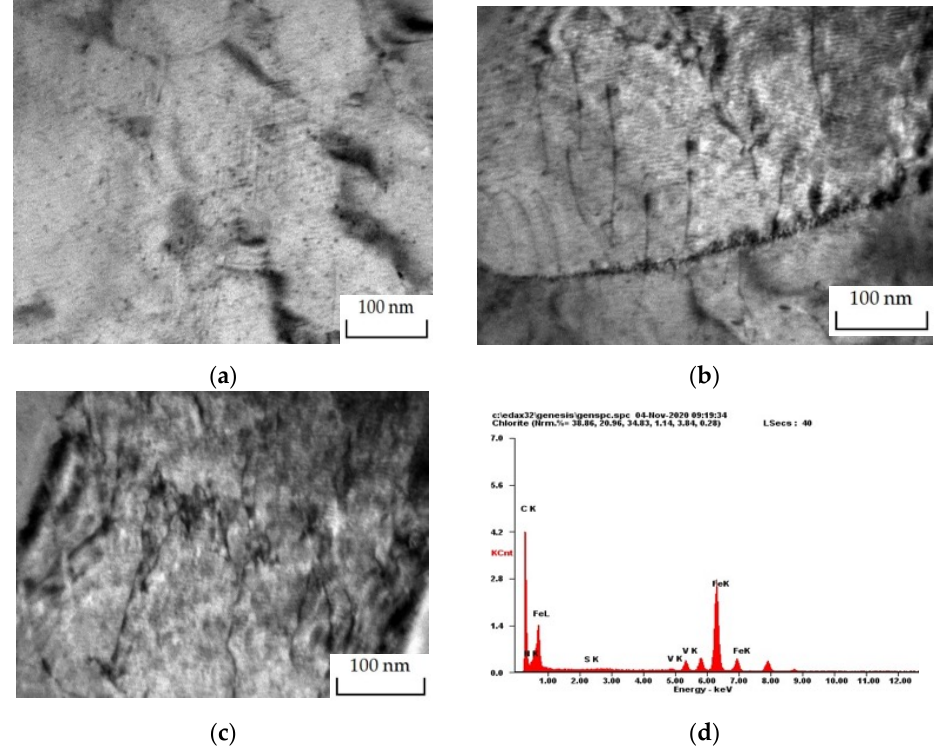
Figure 3. Morphology and distribution of V(C, N) precipitates in the base material of 10 V steel: ( a ) dispersed distribution of V(C, N) precipitates; ( b ) V(C, N) precipitates at the grain boundary; ( c ) V(C, N) precipitates pin dislocation; and ( d ) elemental analysis of precipitate by energy dispersive